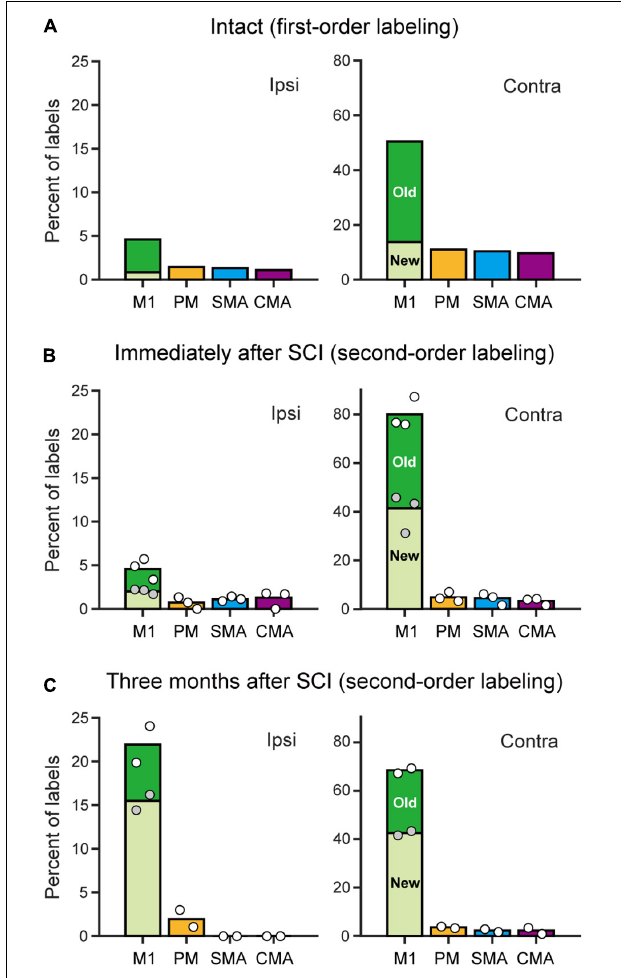
FIGURE 4 | Distributions of monoCSP and diCSP neurons. (A) Summary histograms showing the distributions of retrograde labeling in the frontal motor-related areas after rabies injections into the spinal forelimb segments. The first-order neuron labeling in an intact monkey without monoCSP lesion (Intact). Each ratio was calculated relative to the total labeled neurons in both hemispheres. (B) Same as A, but the second-order neuron labeling obtained immediately after the monoCSP lesion (averaged across three monkeys). The variability of labeled neurons in each case is depicted by circles (monkeys C1–C3 from left to right). White circles, total percentage in each area; gray circles, percentage of labels in “new” M1 relative to the total M1 labels. (C) Same as A, but the second-order neuron labeling obtained 3 months after the monoCSP lesion (averaged across two monkeys). The variability of labeled neurons in each case is depicted by circles (left, monkey D1; right, monkey D2). Left, ipsilateral (Ipsi) to rabies injections. Right, contralateral (Contra) to rabies injections. The ratio of labeled neurons in “old” or “new” M1 relative to the total M1 labels in each hemisphere is depicted in black or white, respectively. Note that the color of the bars for each area corresponds to the one used for the parcellation in Figures 1 – 3 . See Table 1 for the exact number of labeled neurons in each